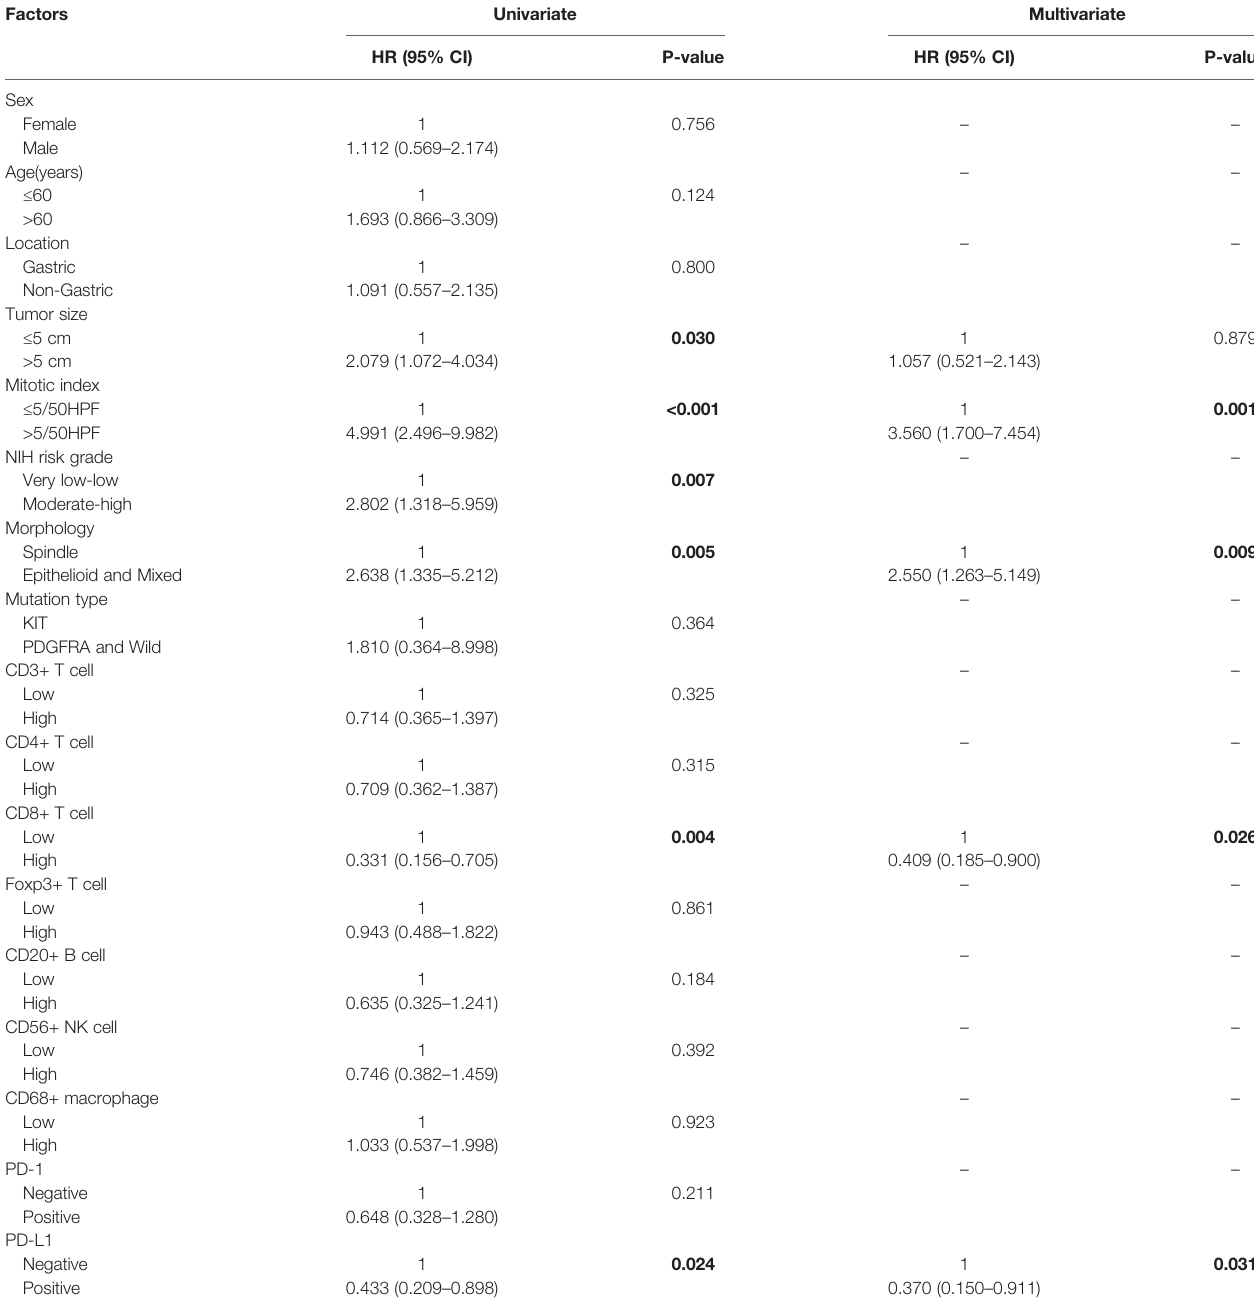
TABLE 4 | Univariate and multivariate Cox regression analysis on variables affecting recurrence-free